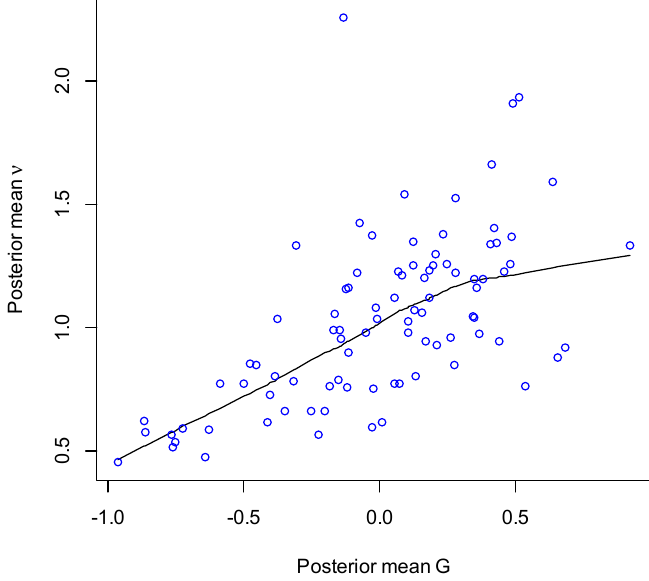
Figure 2. Poor access and emergency admission relative risk.